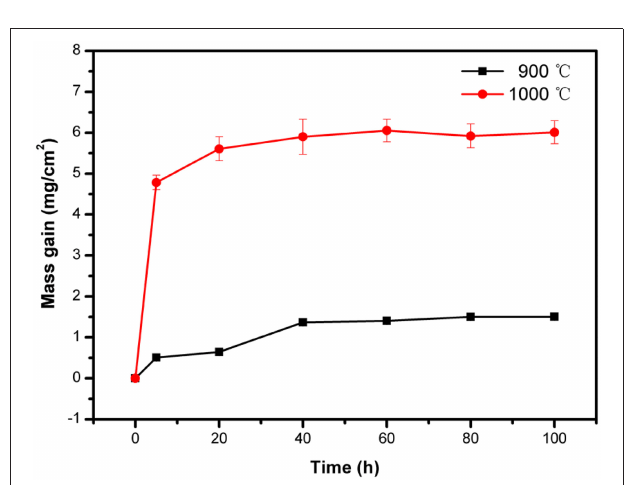
surface of the as-sprayed NiCrAlY coating is covered with ( Figure 8 ), and wear rate ( Figure 10 ) of the coating are